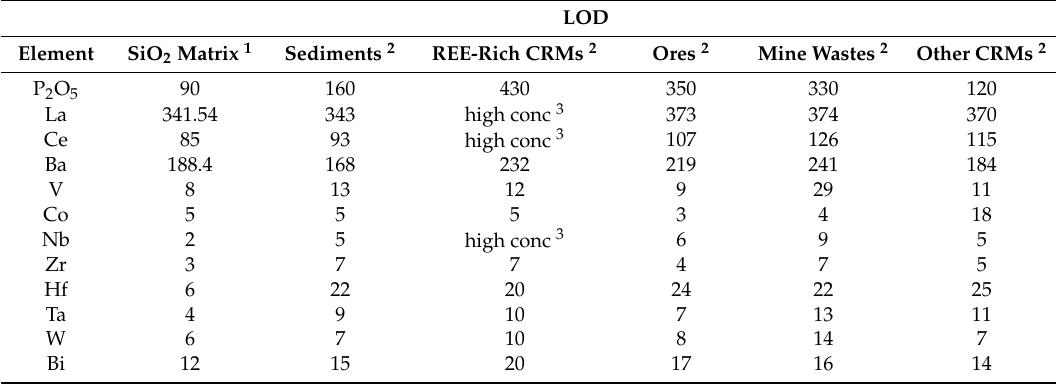
Table 2. Limit of detection (LOD) for SiO 2 matrix and CRM groups. All values are stated as ppm (routinely provided by pXRF instruments, the official unit is mg/kg).